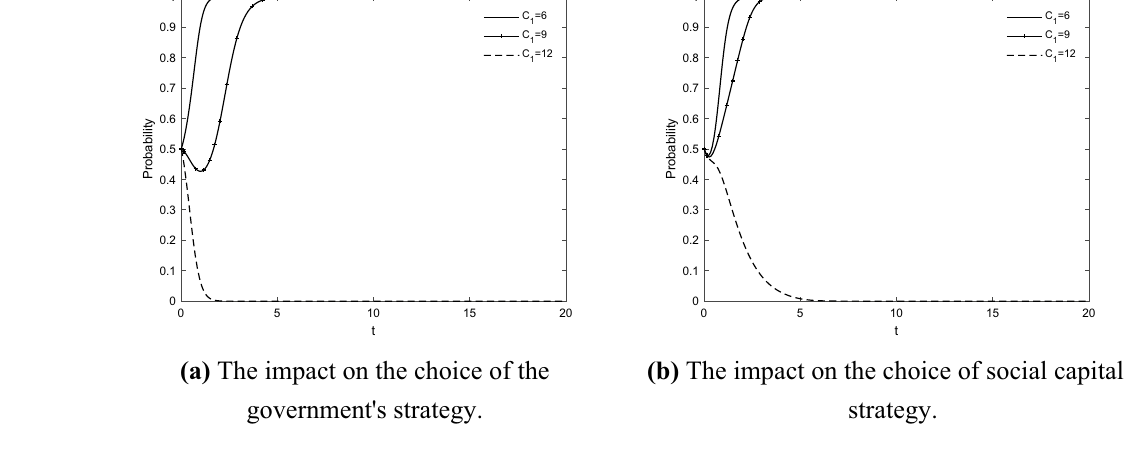
(b) The impact on the choice of social capitals' strategy.